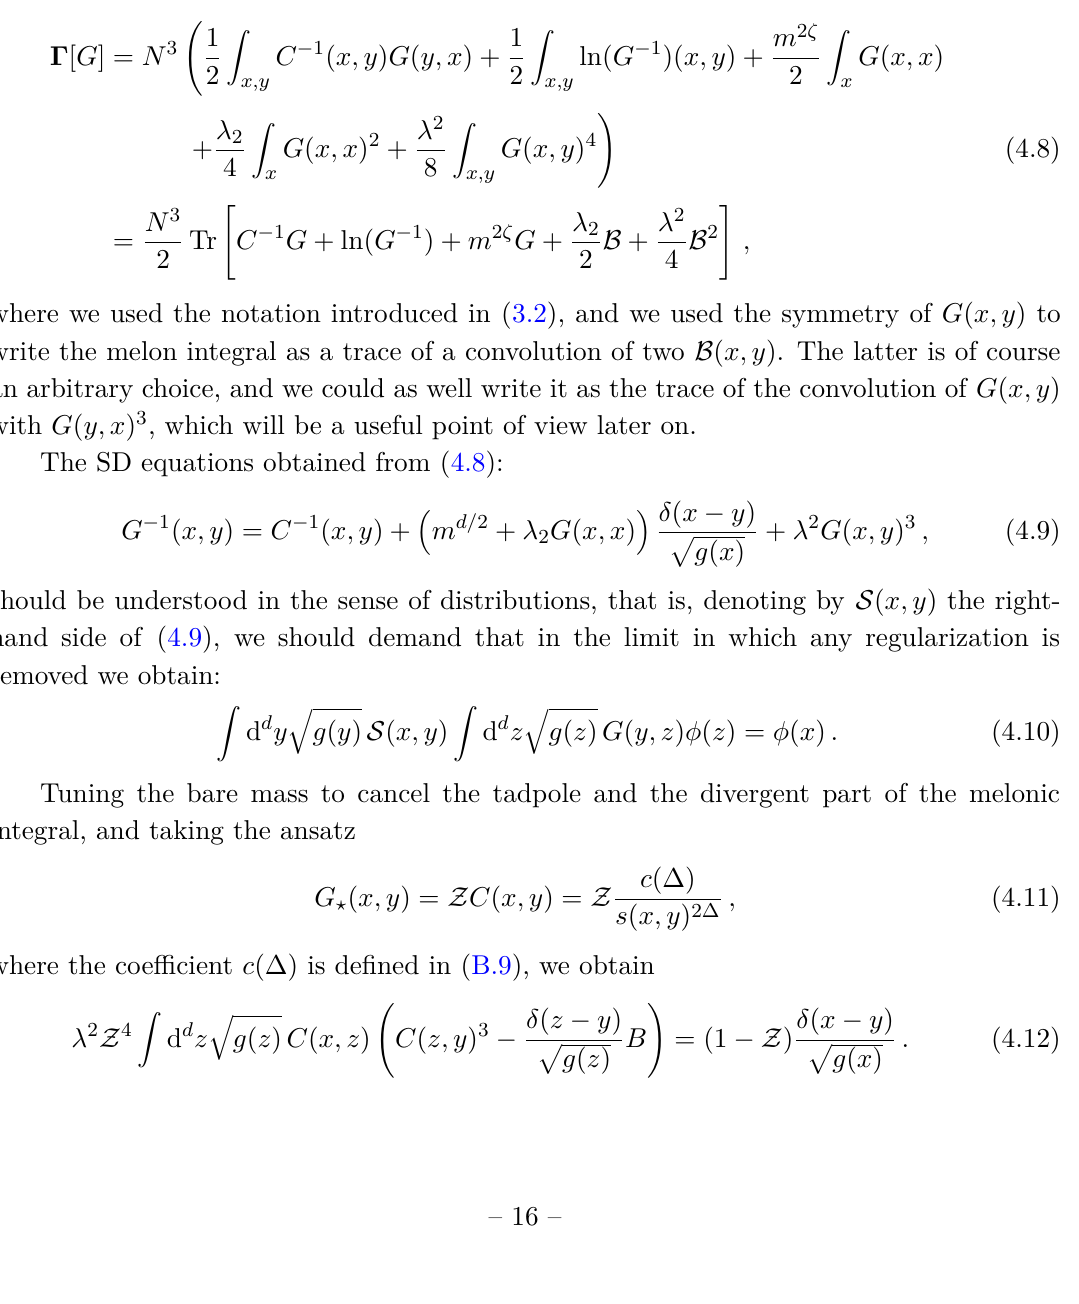
Figure 5 . The only three types of vacuum 2PI diagrams occurring at large N . The tadpole on the left has a two-valent mass vertex. The figure-eight in the middle has a λ the same type as in the O ( N ) model. The melon diagram on the right has two λ vertices, and it is characteristic of tensor